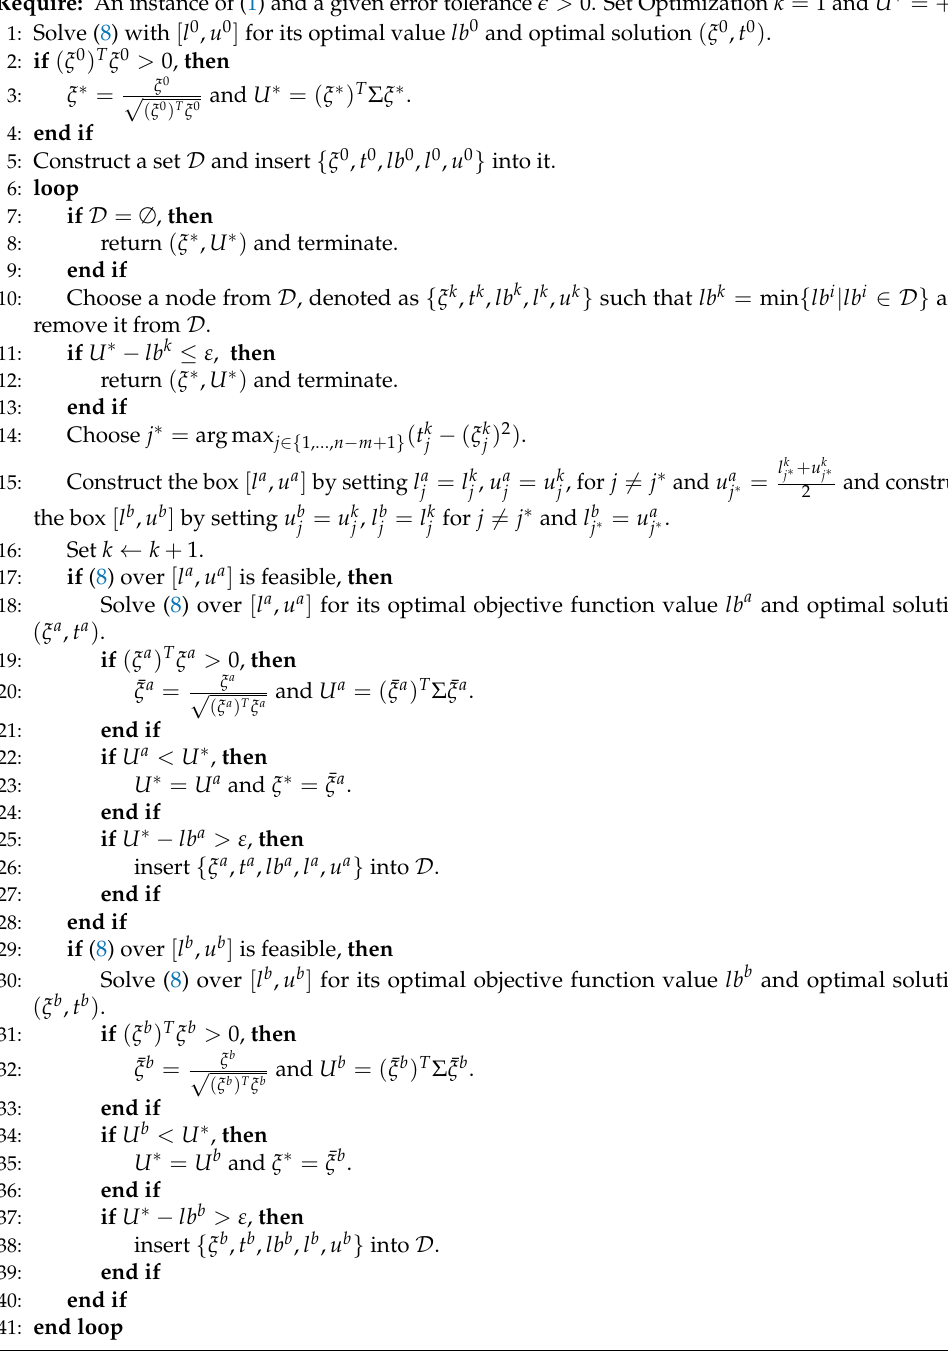
Algorithm 1 A Branch-and-Bound Algorithm for Solving